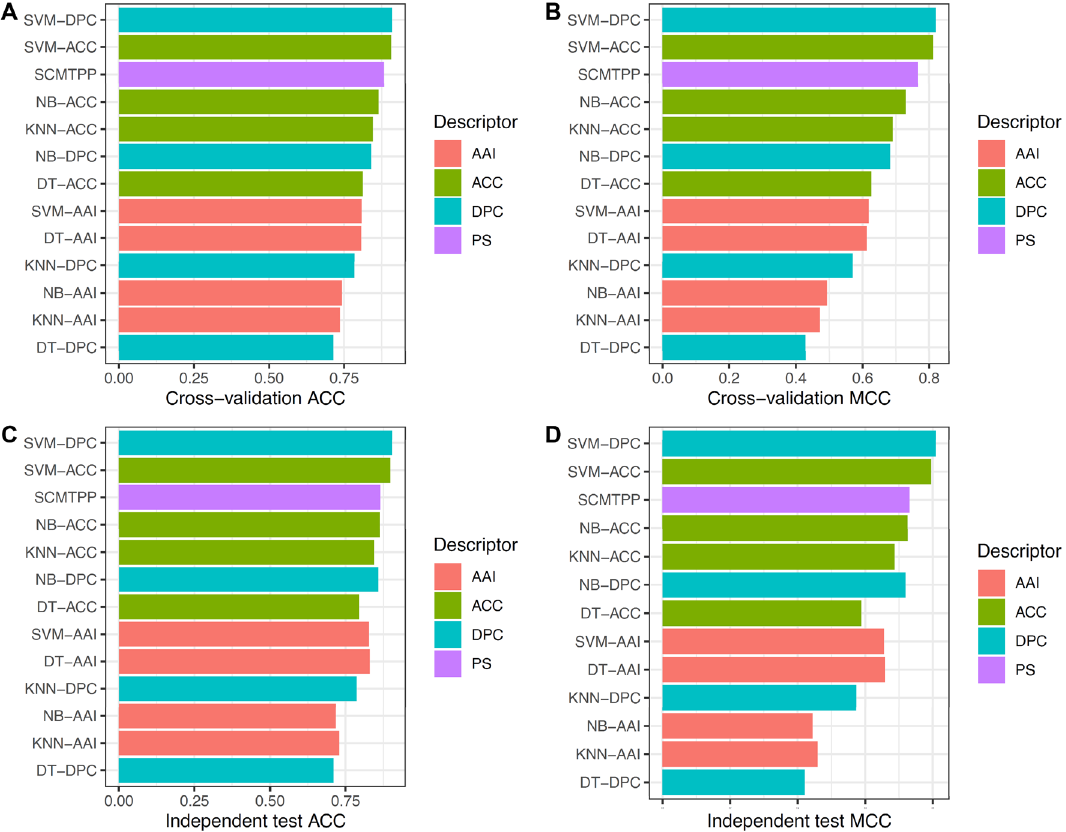
Figure 4. Performance evaluations of SCMTPP and conventional TPP predictors. ( A , B ) tenfold cross- validation of ACC and MCC from SCMTPP versus conventional TPP predictors. ( C , D ) Independent test of ACC and MCC from SCMTPP versus conventional TPP predictors.